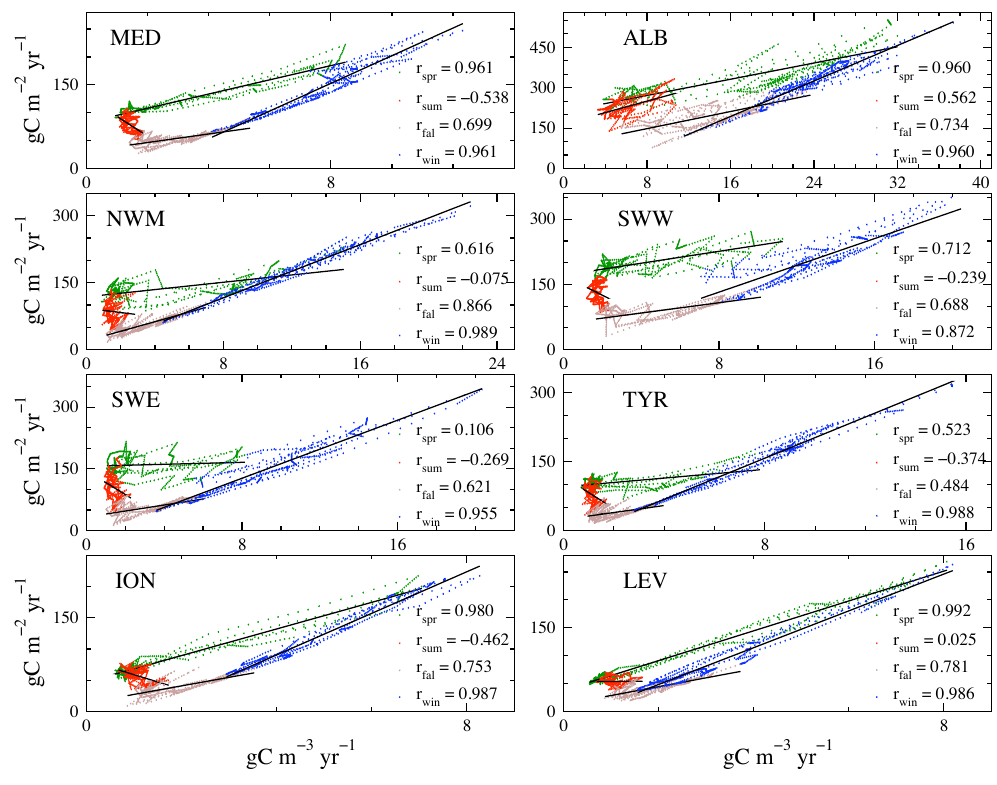
Fig. 10. Scatter plots of integrated (gCm − 2 yr − 1 ) versus surface (gCm − 3 yr − 1 ) net primary production: each point represents the 10-day regional average in the period 1999–2004 for the MS and the 7 areas defined in Fig. 1. Points are colored according to seasons: winter (blue, January–February–March), spring (green, April–May–June), summer (red, July–August–September) and fall (brown, October–November– December). Black lines represent the linear regressions, whose correlation coefficients r are also